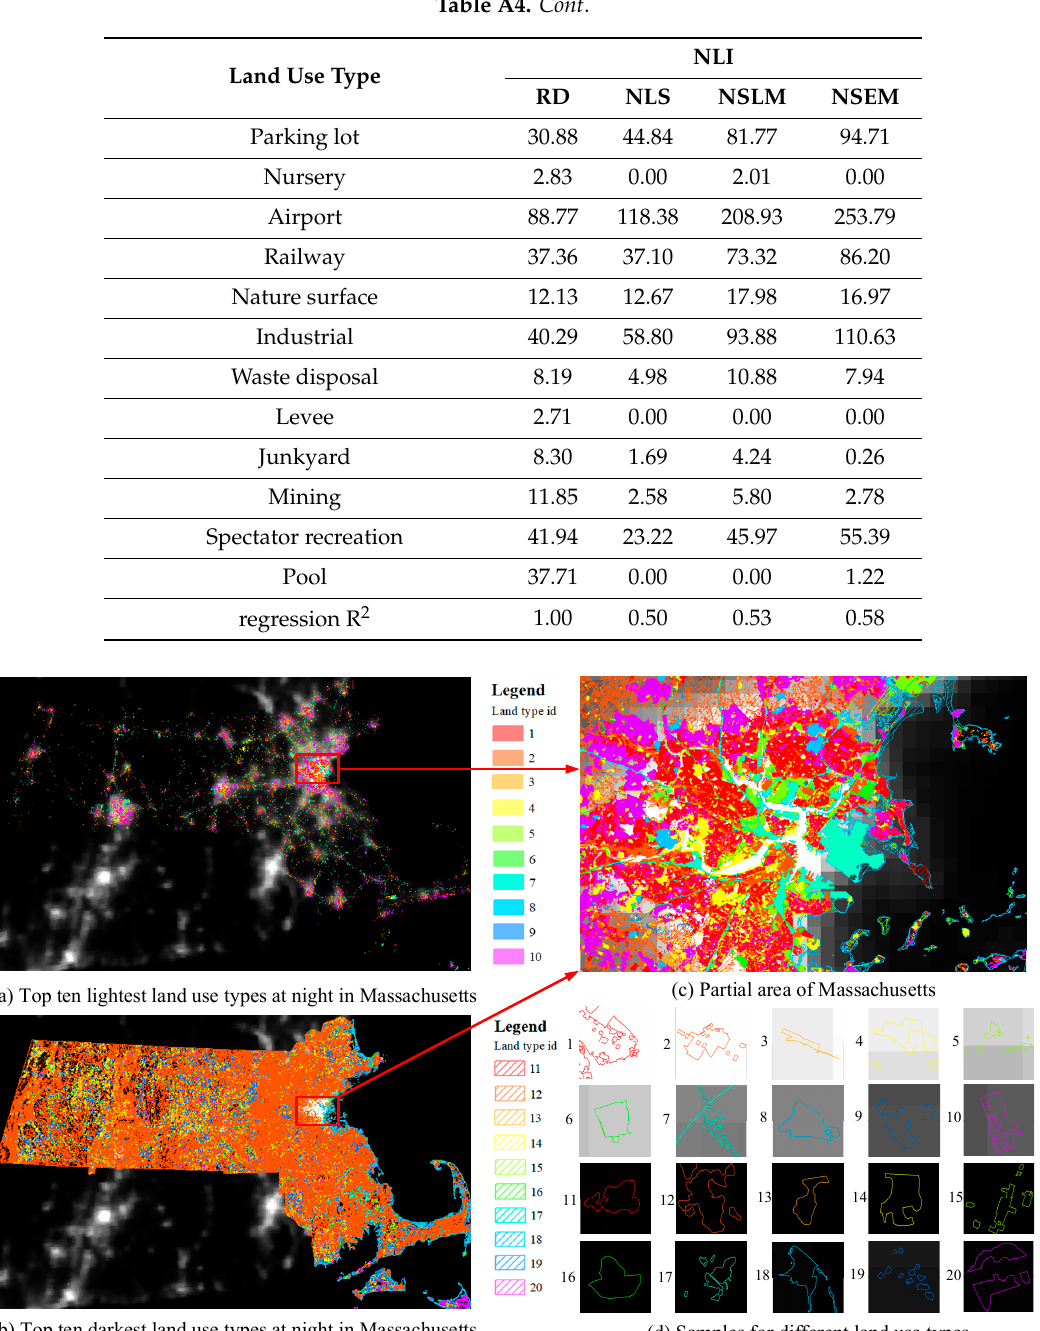
Figure A1. Top ten lightest and darkest land use types at night in Massachusetts.